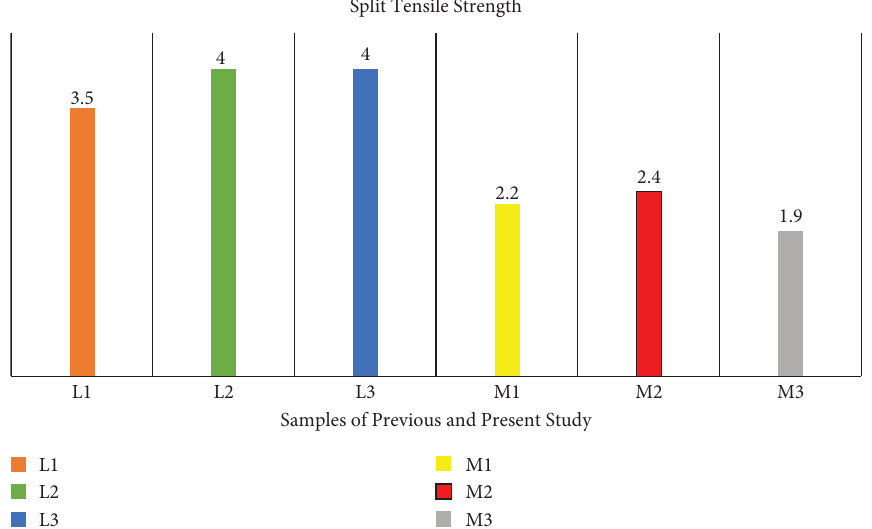
Figure 15: Comparison of split tensile strength between Subash et al. [6] and the present study.